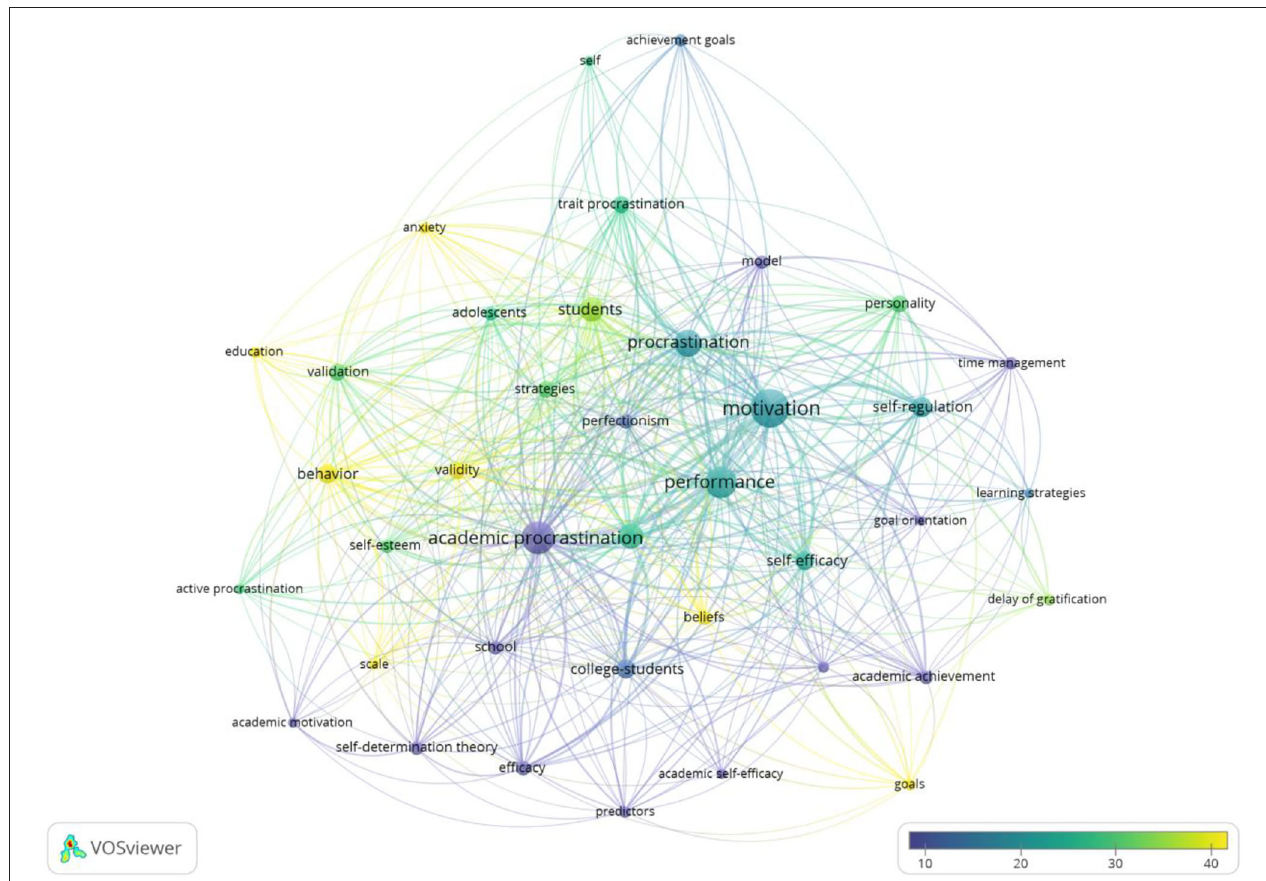
FIGURE 11 | Overlay visualization based on motivation link-weights and citation